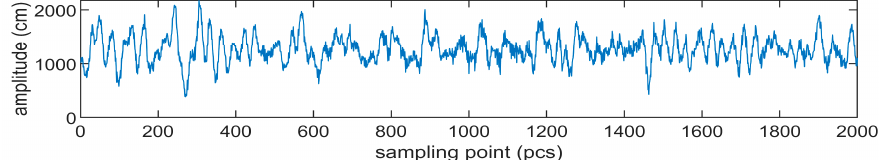
Figure 8. Actual micro-seismic data.